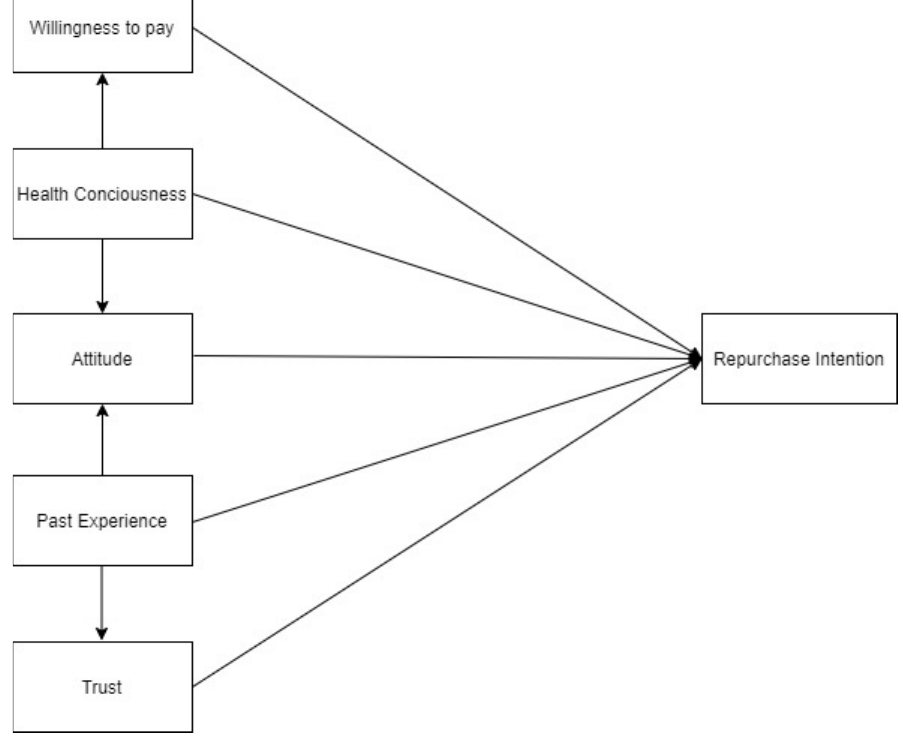
Figure 1. Conceptual model.